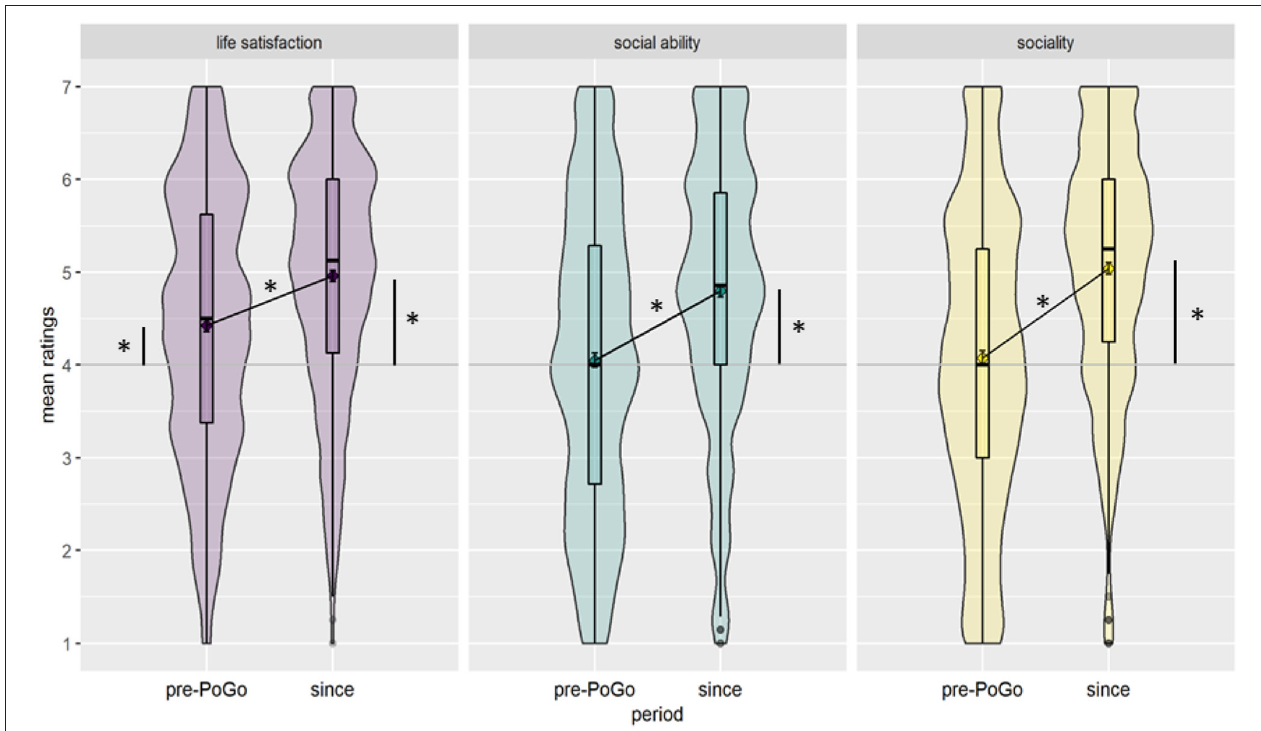
FIGURE 1 | Ratings of perceived life satisfaction, social ability, and sociality. The ratings for the time period before playing PoGo (pre-PoGO) and since playing PoGo (since) are shown. Data distributions are shown by the violin plots. The rhombus within the boxplots represents the sample mean while the black horizontal line represents the median. The grey line at the value 4 represents the middle of the rating scale, i.e., neutral rating, while all ratings above 4 represent positive and below 4 negative perceptions. Error bars represent 95% confidence intervals of the means. The diagonal lines show the significant comparisons between the time periods; the vertical lines show the significant comparisons to the midline of the rating scale. * p <